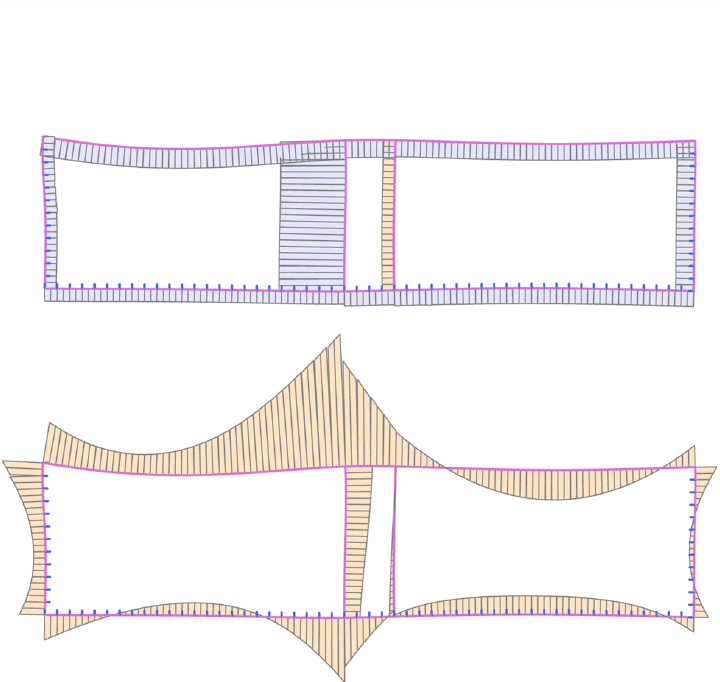
Figure 5. Axial force (top; compressive blue) and bending moment (bottom) after approx.. 60 min of fire exposure (beginning of the cooling phase).